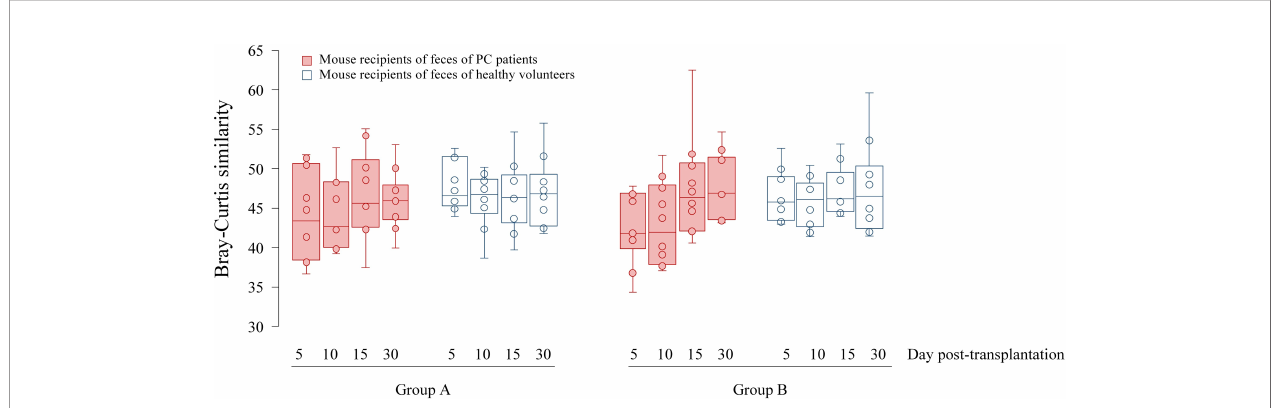
FIGURE 3 | Boxplots showing Bray-Curtis similarities of fecal microbial communities of mice on day 5, 10, 15 and 30 after transplantation. Since each human feces were transplanted into two mice denoted Group (A, B), microbiota analyses were performed twice.